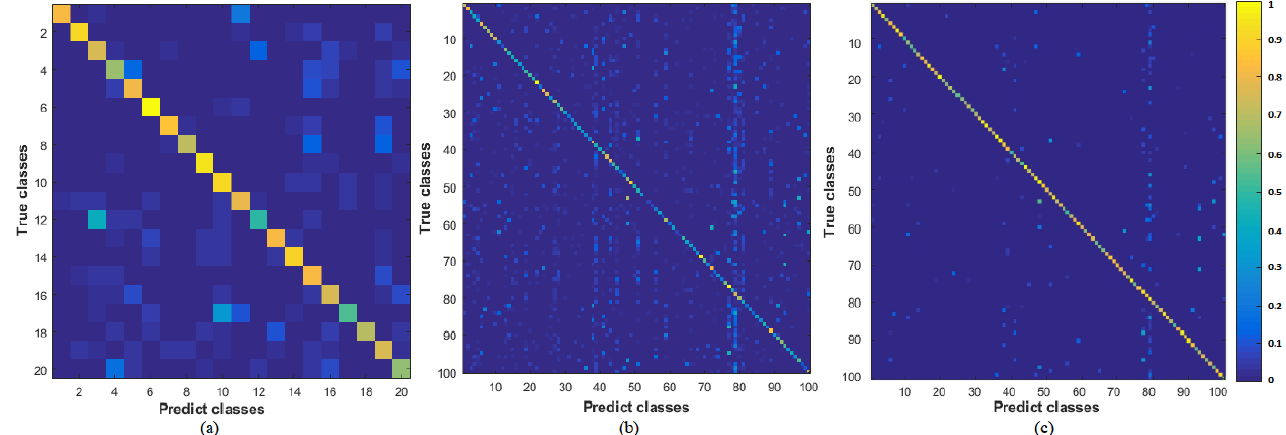
Figure 3. Confusion matrices for the PIL method on the CIFAR-100 dataset. ( a ) PIL is first trained with 10 classes (1–10), and then incrementally trained for additional 10 classes (11–20) (without using old data). ( b ) PIL incrementally trained on all 100 classes (adding 10 classes per incremental step), without using old data and ( c ) using exemplars from the old classes. Table 1. Percentage errors incurred on old and new classes using the PIL method (FC trained using exemplars).